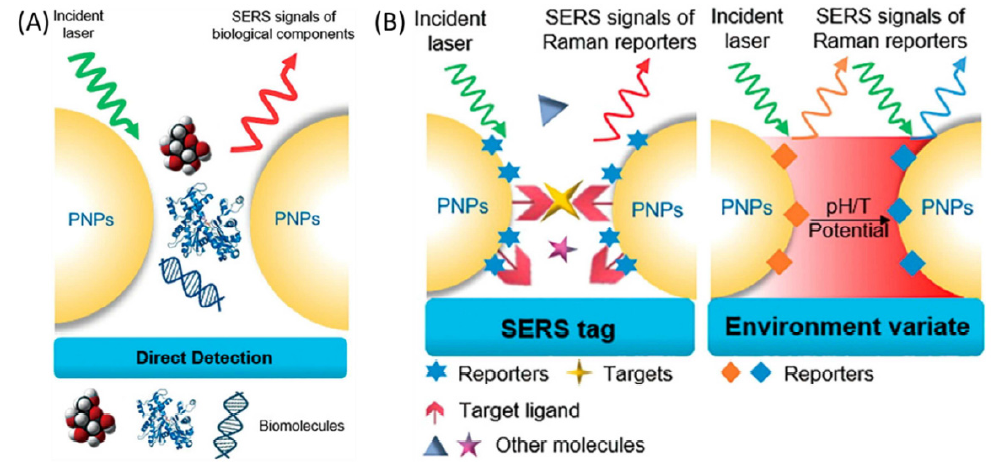
Figure 14. Illustration of the design of the SERS-based biosensor. ( A ) Direct SERS detection in which the intrinsic SERS signals emit from the substrate without labeling molecules; ( B ) indirect SERS detection in which the generated SERS signals from Raman reporters alter due to the presence of bound targets or change in the environmental properties. Reprinted with permission from Ref. [190].